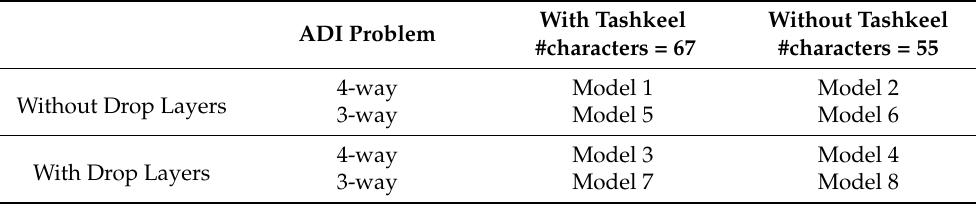
Table 3. The different tested models for the CNN approach.